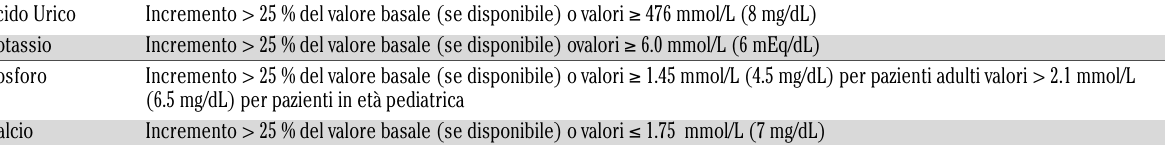
Tabella 1. TLS laboratoristica. Acido Urico